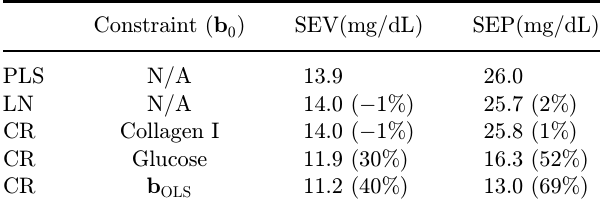
Table 3. Comparison of di®erent calibration methods using simulated data with substantial spurious correlations. See text for details. Column designations are the same as for Table 2.